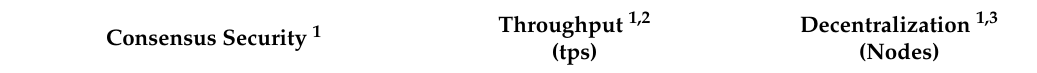
Table 6. Comparison of the public blockchain systems (presented in Section 5.3) in relation to the blockchain trilemma properties (security, throughput, and scalability) for